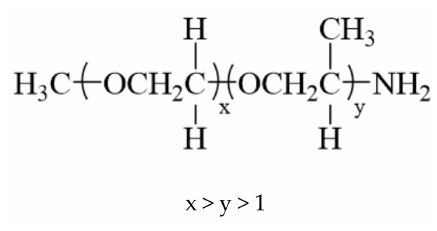
Figure 1. The structure of PEA.